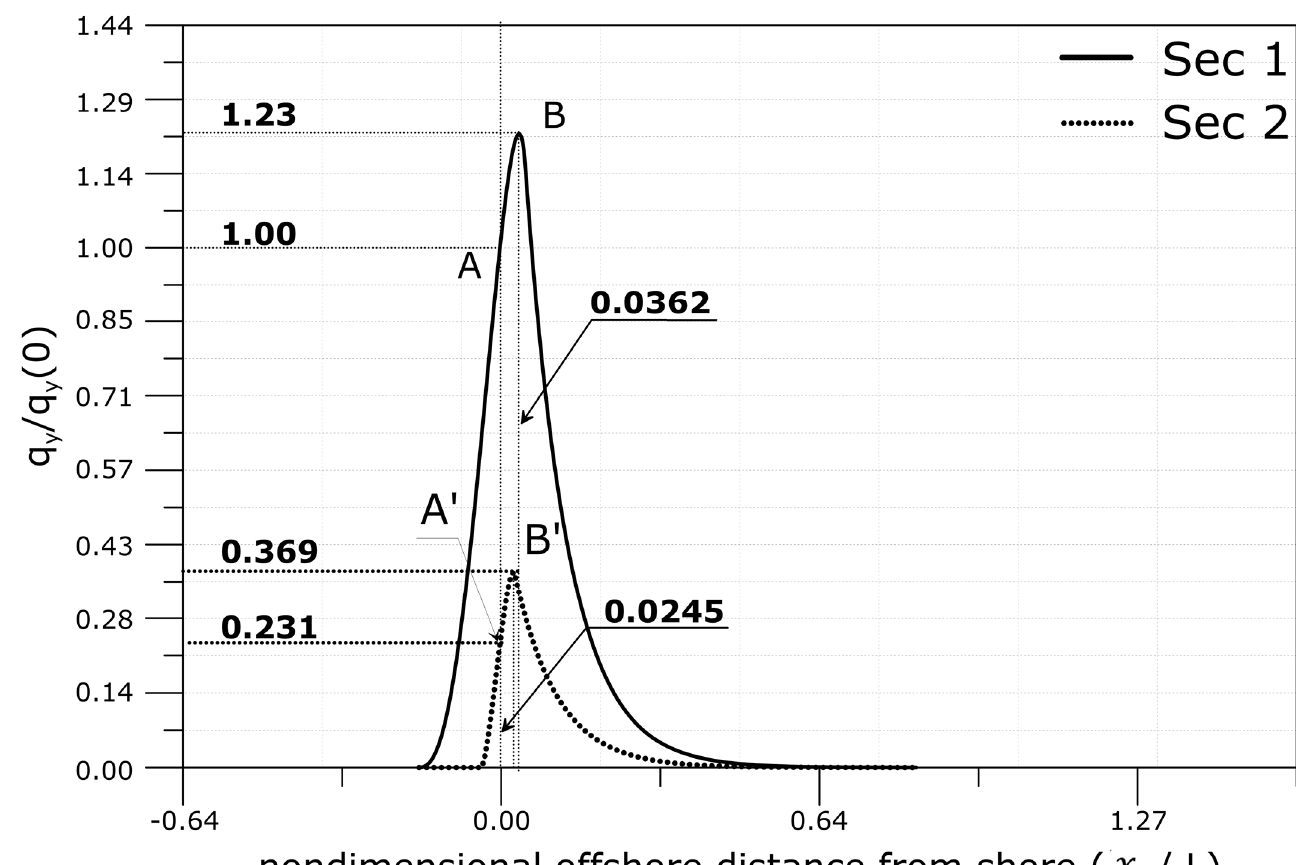
Figure 7. Alongshore fluid mass transport distribution.